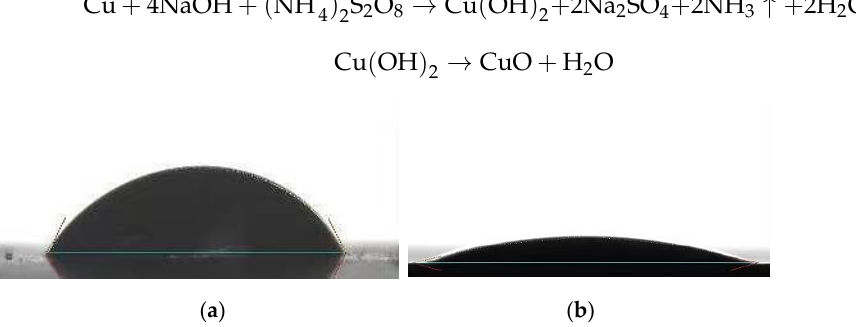
Figure 4. Contact angles of surfaces with deionized water: ( a ) copper surface; ( b ) copper oxide surface. The contact angle of deionized water with copper oxide was measured to be 13.5 ◦ , as